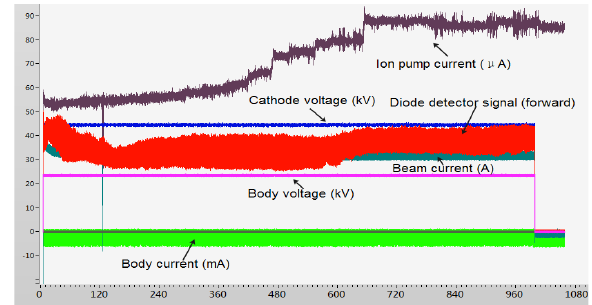
Fig. 9. The waveforms of the 550W 1000s pulse of the #3